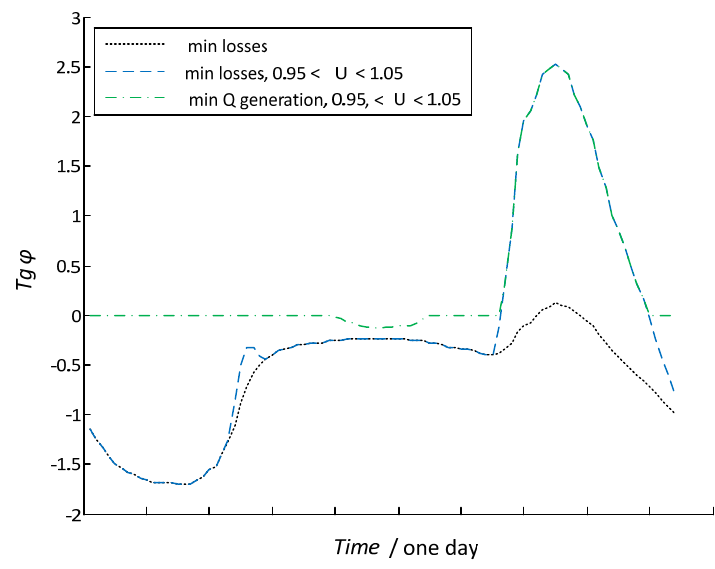
Figure 4. Reference tg φ tracking of one feeder.